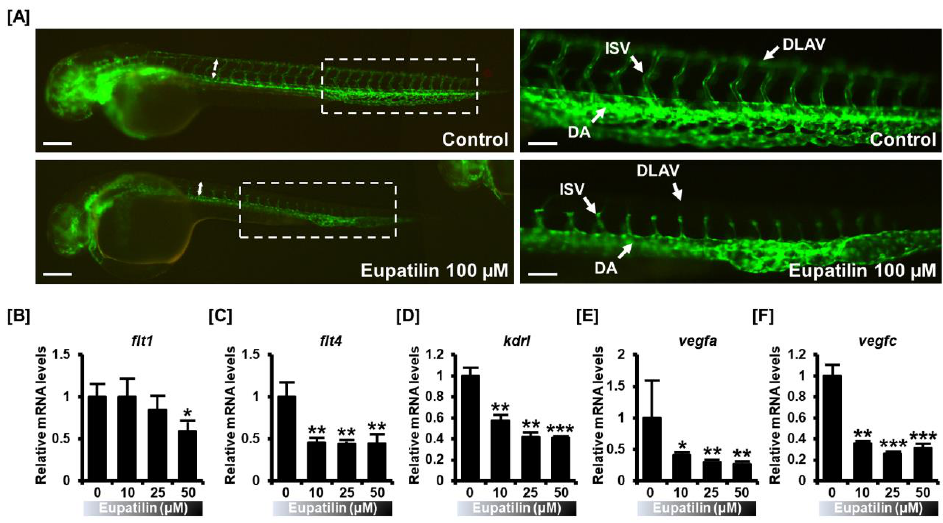
Figure 8. In vivo validation of an inhibitory e ff ect on angiogenesis by eupatilin. ( A ) A zebrafish transgenic model ( fli1:EGFP ) was used to determine the physiological anti-angiogenic e ff ects of eupatilin. Eupatilin-treated embryos indicated dorsal longitudinal anastomotic vessel (DLAV) and dorsal aorta (DA) defects and branching intersegmental vessels (ISVs). The scale bar indicates 300 µ m in the first vertical panels and 60 µ m in the second vertical panels [B–F] Expression of angiogenesis-associated genes, including flt1 ( B ), flt4 ( C ), kdrl ( D ), vegfa ( E ), and vegfc ( F ), were analyzed in eupatilin-treated or untreated zebrafish fli1 embryos. The experiments were performed in triplicate. Data represent the mean ± standard deviation, and asterisks indicate that the e ff ect of treatment was statistically significant (* p < 0.05, ** p < 0.01, and *** p < 0.001).